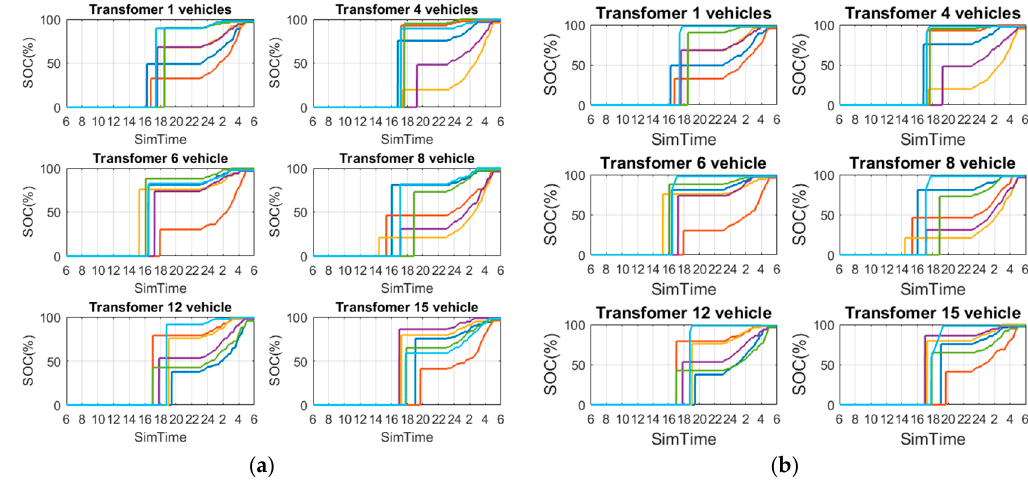
Figure 7. PEV charging paths with ToU + DLC + optimal charging. ( a ) A 100% participation rate optimal PEV charging scenario; and ( b ) an 80% participation rate of optimal PEV charging scenario (20% uncontrolled PEV charging).